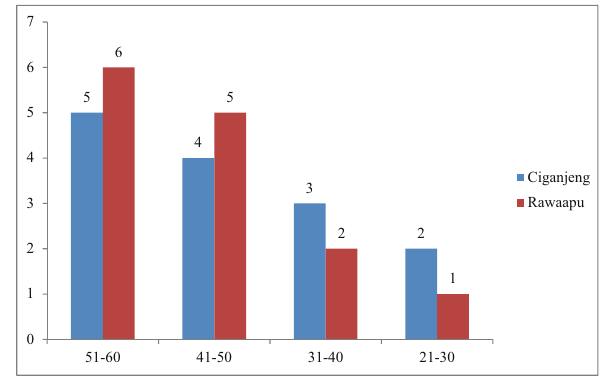
Figure 3: Age distribution of farmers researchers.